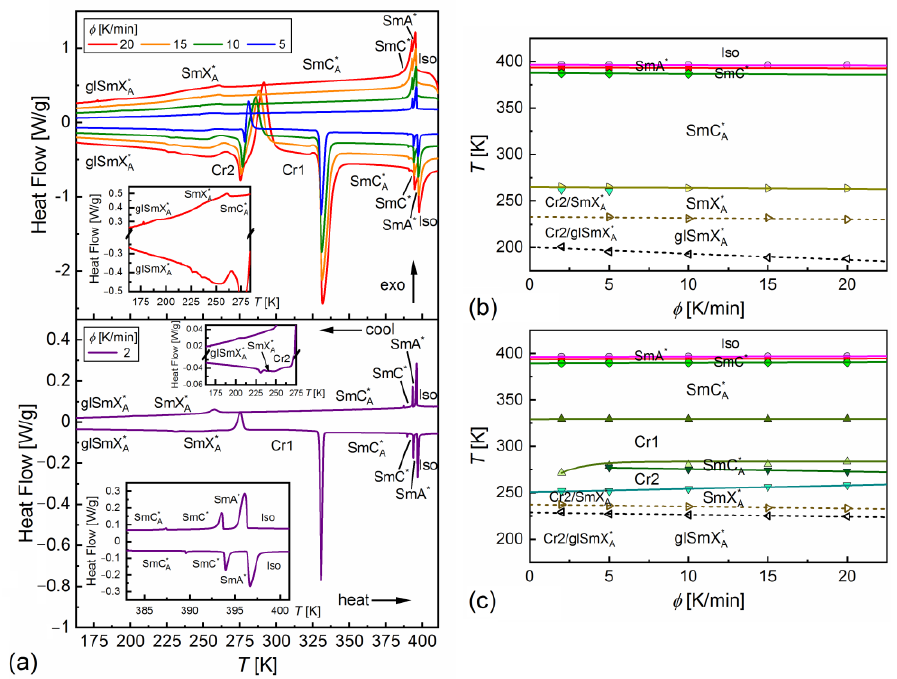
Figure 2. DSC curves collected for 7HH6 ( a ) and phase transition temperatures during cooling ( b ) and subsequent heating ( c ) at different rates of 2–20 K/min. The lines in ( b , c ) are guide to eyes. Table 1. Transitions between the smectic phases of 7HH6 investigated by DSC: onset temperature and peak temperature of anomalies, enthalpy change and entropy change obtained on heating and (cooling). Results are for 2 K/min, except the last row, which is for 20 K/min.